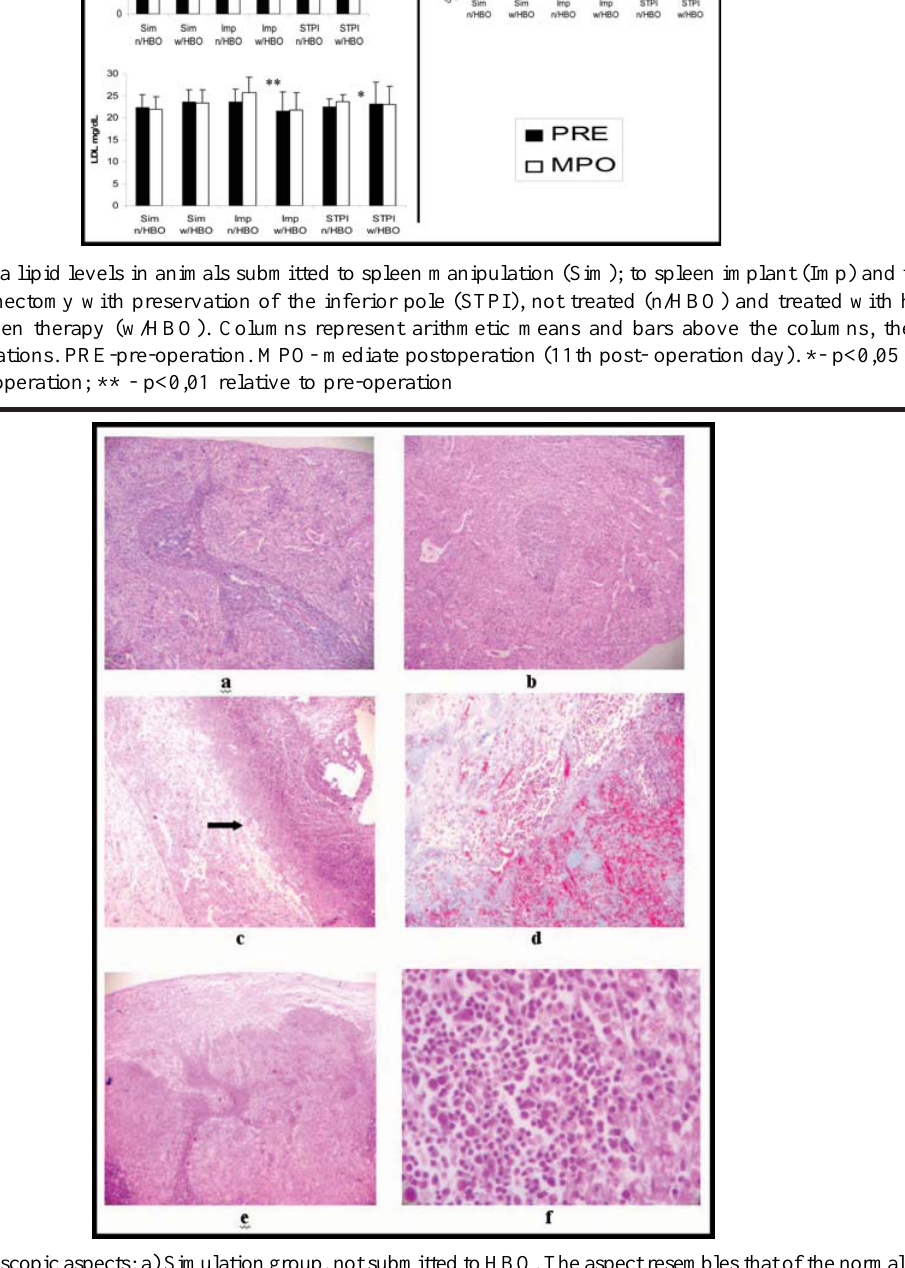
FIGURE 3 - Micropscopic aspects: a) Simulation group, not submitted to HBO. The aspect resembles that of the normal spleen (40 x HE magnification); b), Simulation group, submitted toHBO show similar aspect to the former (40 x HE magnification); c) Auto-implanted group, not submitted to HBO. Sub-total coagulant necrosis (arrow), intense periesplenic fibrosis, macrophage centrípetal infiltration and areas of acinar atrophy of the pancreas (40 x HE magnification); d) Auto- implant group with HBO showed fibrosis, but no areas of coagulant necrosis, a perisplenic more preserved tissue at 40 x HE magnification) ; e) STPI group, not submitted to HBO, showing extensive areas of coagulant necrosis (40 x HE magnification); f) STPI group submitted to HBO, showing a more preserved peri-arteriolar sheath and a higher lymphoid population (100 x, HE